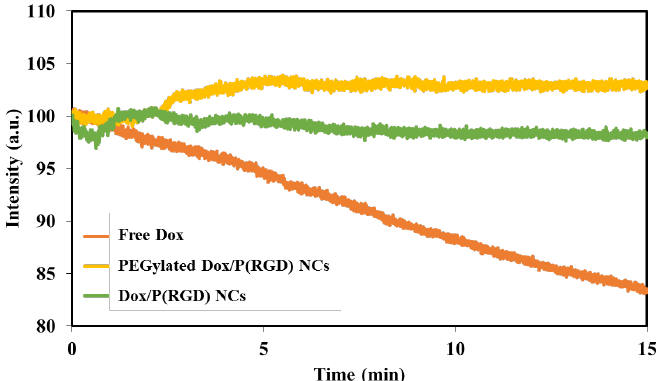
Figure 5. Photostability of free Dox (orange line) and non-PEGylated (green line) and PEGylated (yellow line) Dox/P(RGD) NCs. Illumination was performed continuously at 490 nm for a period of 5 min.